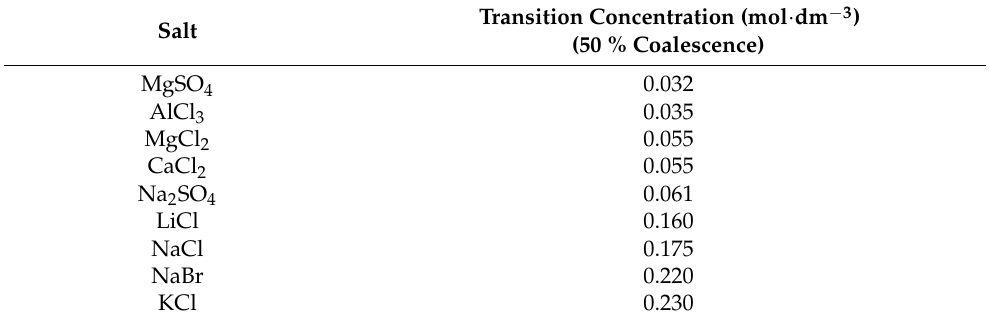
Table 2. Bubble coalescence transition concentration in different inorganic electrolytes